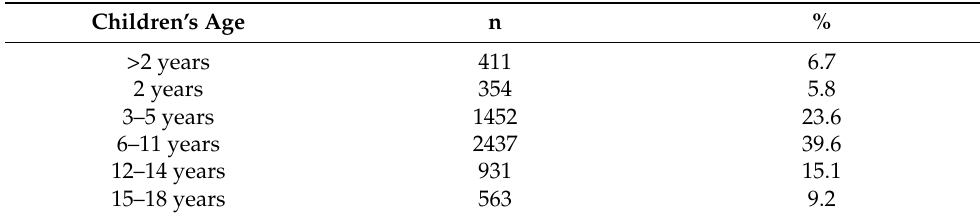
Table 2. Children’s age in our cohort.